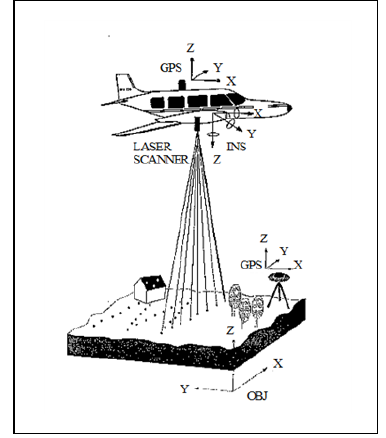
Figure 1. Airborne LiDAR (Ackermann, 1997) Consequently, upon the mentioned definitions, this bare-earth DEM is generally synonymous to Digital Terrain Model (DTM) (Figure 2). A digital surface model (DSM) is usually constructed using automatic extraction. DSM represents top faces of all objects on the terrain (both vegetation and manmade features) or terrain itself in open areas (Croneborg, L et al.,